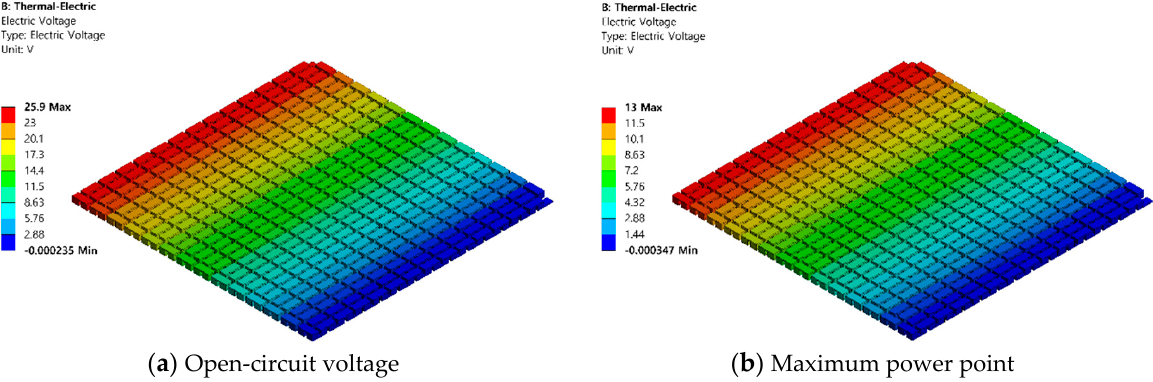
Figure 14. Electrical potentials across TEG module at open-circuit voltage and MPP. (PF heat sink- based, H f = 28.6 mm, V in = 3 m/s and T in = 600 °C ).